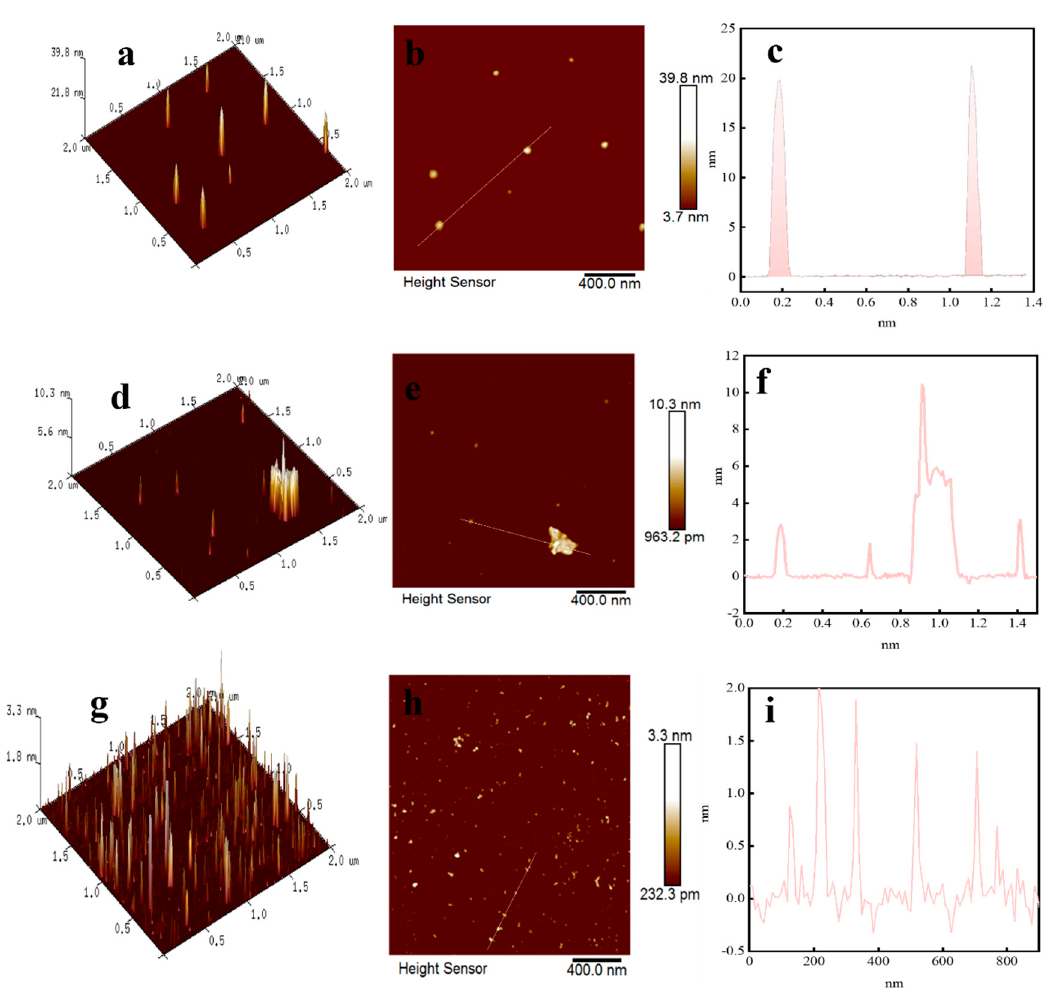
Figure 8. AFM image: ( a – c ) original samples; ( d – f ) non-enhanced acid-leaching residues; and ( g – i ) enhanced acid-leaching residues.